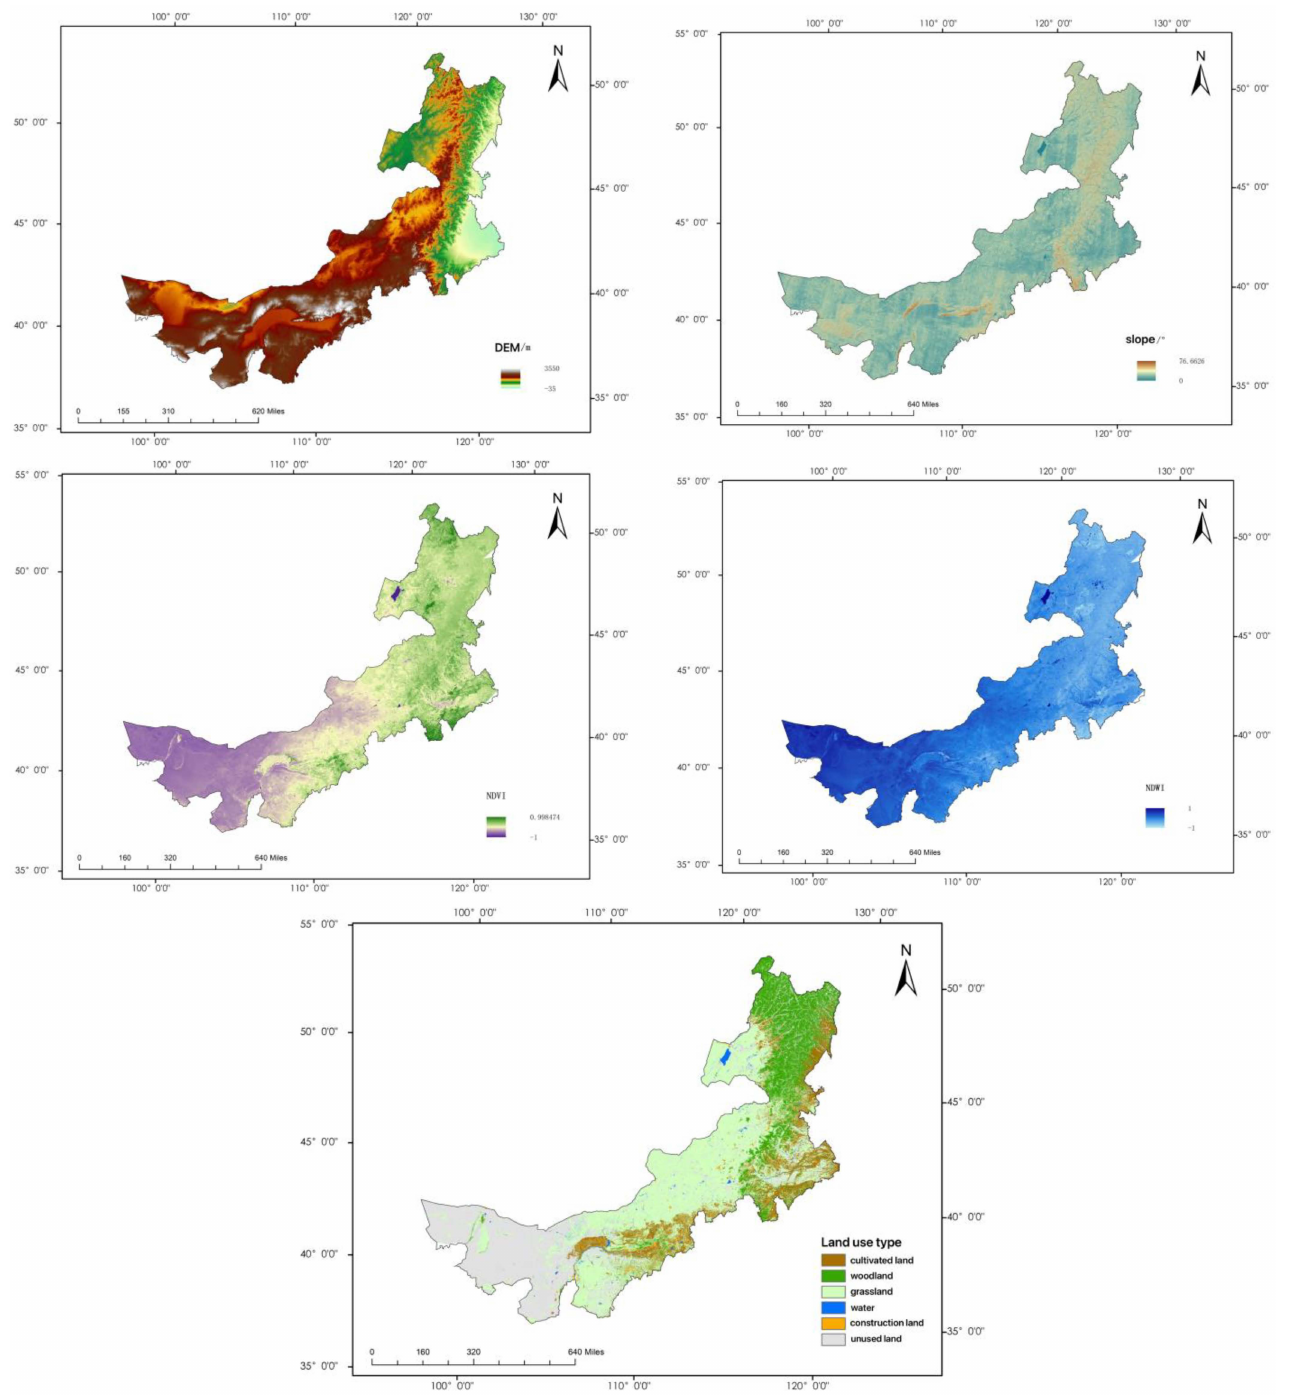
Figure 3. Ecological resistance factor in the study